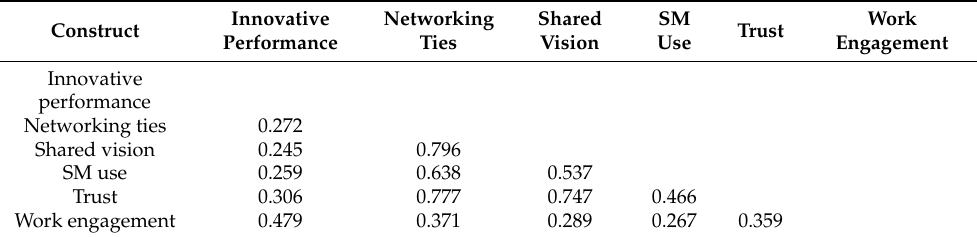
Table 5. Heterotrait-Monotrait Ratio of Correlations (HTMT).